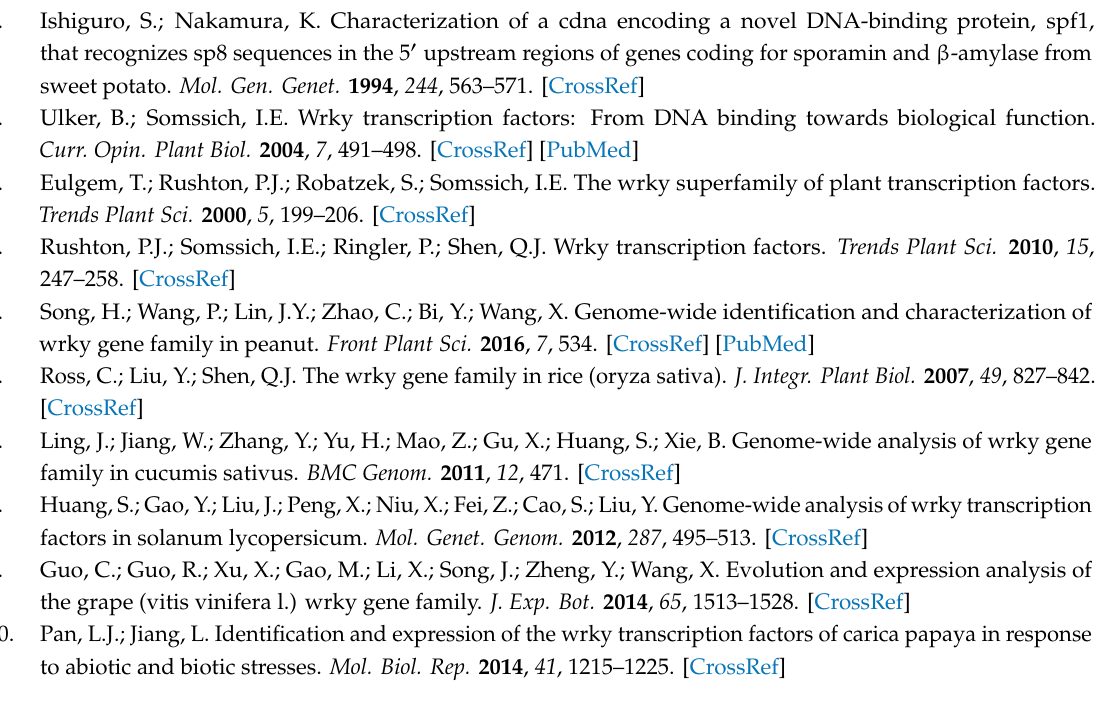
Figure S1: Gene structures of the CcWRKYs , blue boxes represent CDS regions, and solid lines indicate intron regions. Table S1: List of primers used in this study. Table S2: Characteristic features of WRKY Transcription factor gene family identified in Co ff ea Canephora , the red color letters indicate the variant WRKY domain. Table S3: Potential WRKY target genes in Co ff ea canephora , genes with at least three W-box elements in their putative promoters were consider as the potential CcWRKY target genes. Table S4: Potential CcWRKY target genes involved in response to cold stress process. Table S5: Information for 10 selected target genes of CcWRKYs in Co ff ea canephora for qRT-PCR verification, the co-expressed CcWRKYs were the CcWRKY genes that had Pearson correlation coe ffi cients (PCC) ≥ 9.0 with the putative targets based on the Ct value. “ ” indicates no correlational CcWRKY